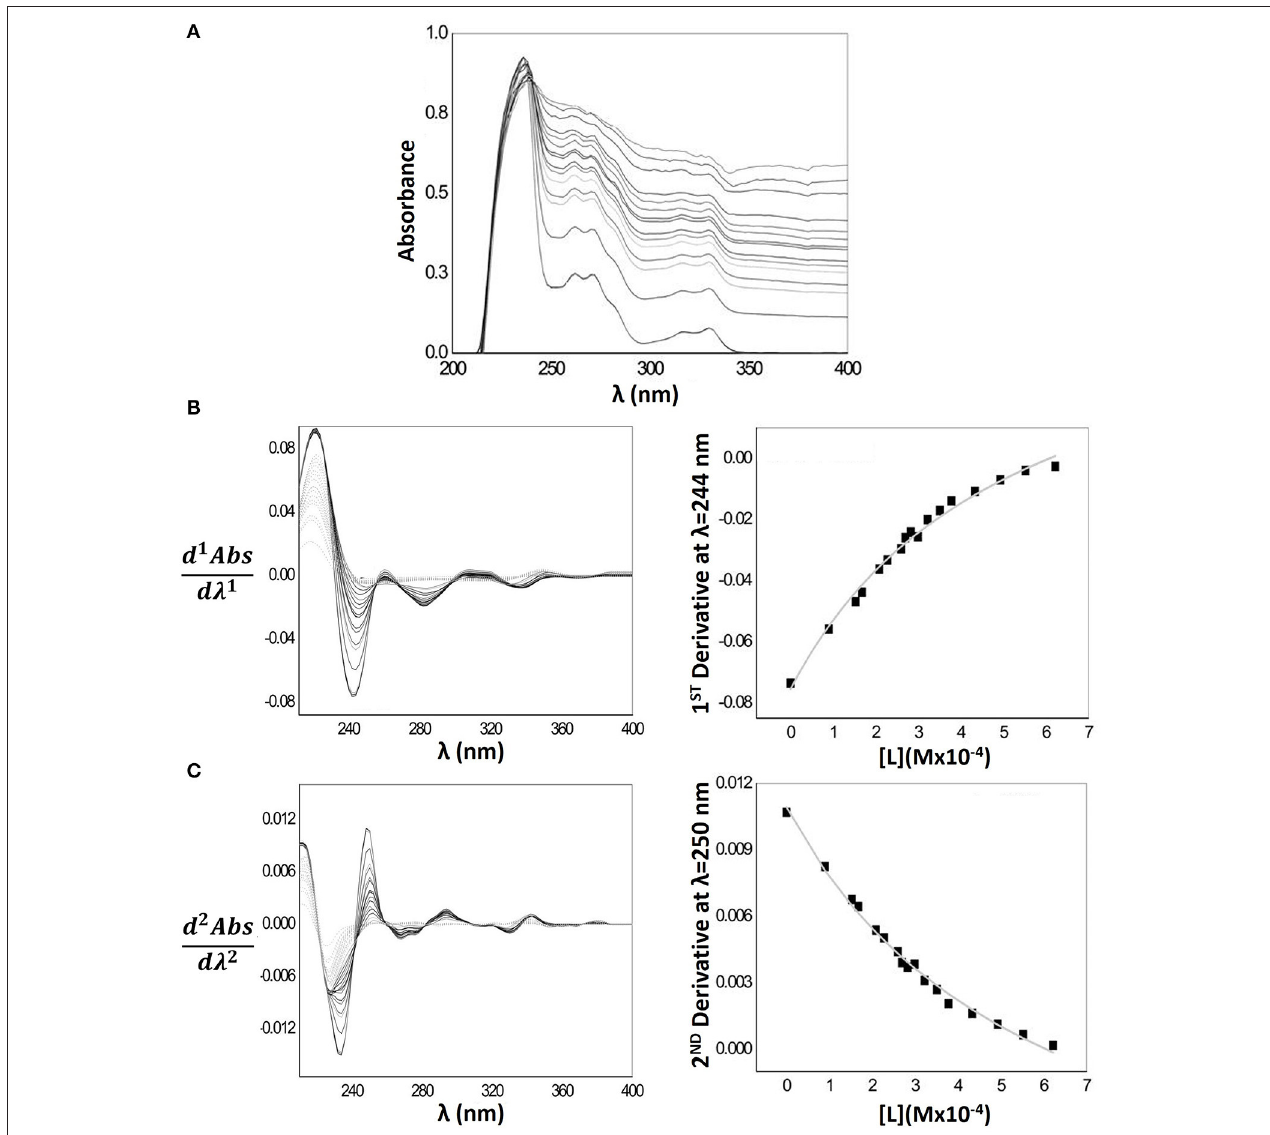
FIGURE 4 | (A) Naproxen absorption spectra with increasing concentrations of MLVs of EPC (0–622 µ M) in Hepes buffer pH = 7.4 and I = 0.1M (B) First derivative spectra (left) and correspondent nonlinear fitting (right) of derivative absorbance values at λ max = 244nm as a function of lipid concentration [L]. (C) Second derivative spectra (left) and correspondent nonlinear fitting (right) of derivative absorbance values at λ max = 250nm as a function of lipid concentration [L].